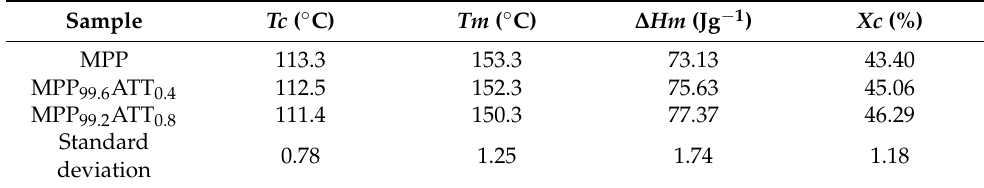
Table 4. Thermogravimetric/differential analysis of MPP/ATT nanocomposites.